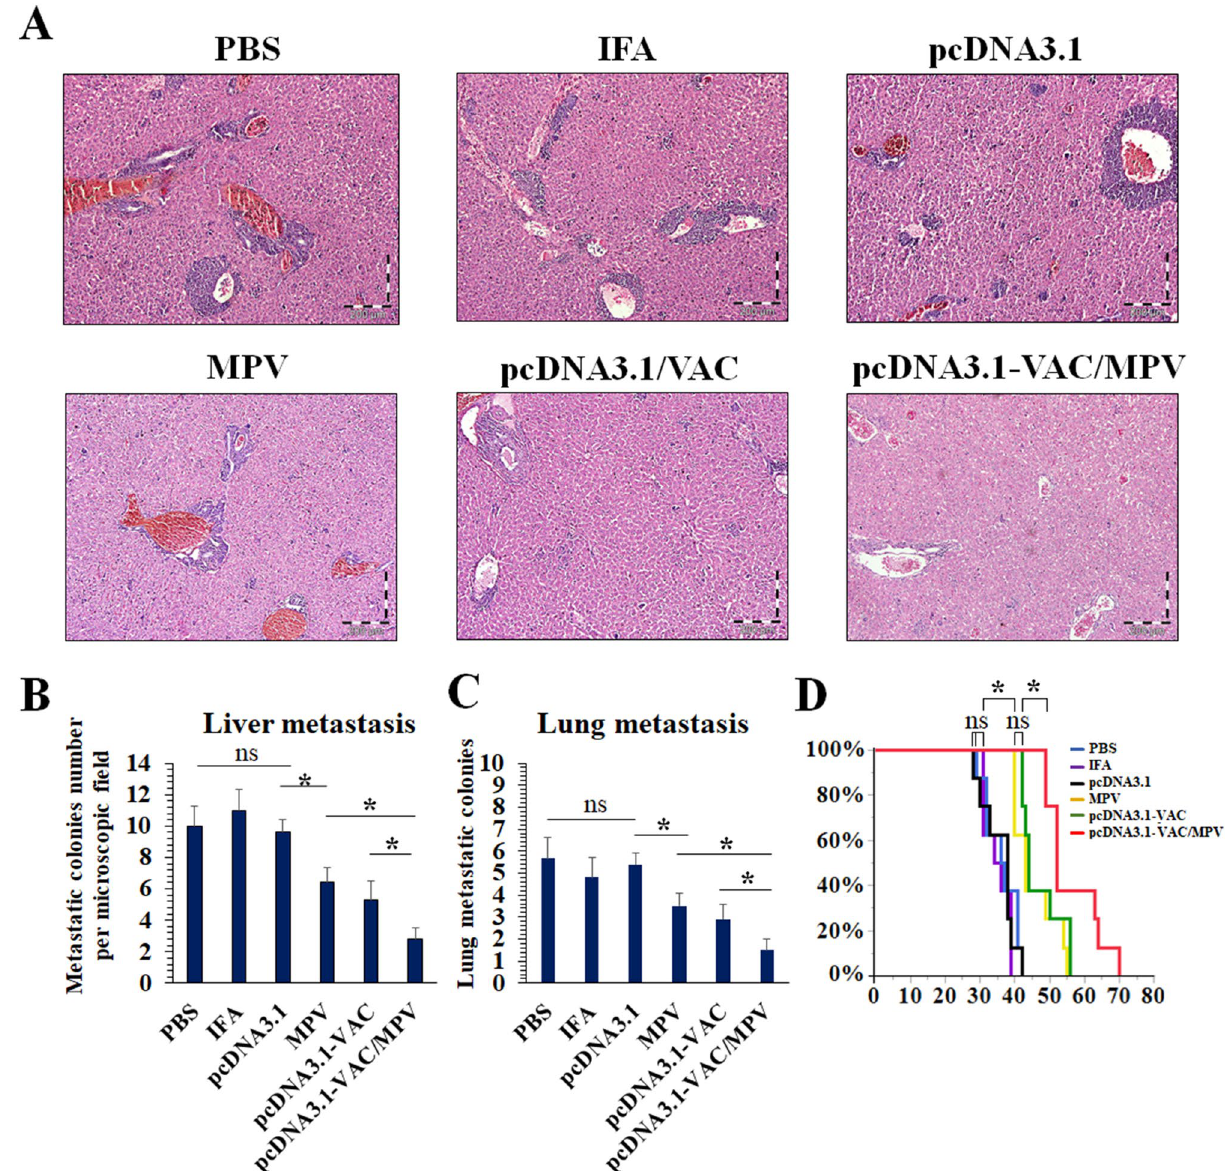
Figure 4. Metastasis and survival time evaluation at different immunization groups. ( A ) H&E stained sections of the immunized mice liver at 40th day after the cancer cells implantation (n = 5). ( B ) Mean metastatic colonies per microscopic field of the immunized mice at 40th day after the cancer cells implantation (n = 5). ( C ) Mean metastatic colonies of harvested lungs at 40th day after the cancer cells implantation (n = 5). ( D ) Kaplan–Meier survival curves of tumor-bearing mice at different immunization groups. (*: 0.05 ≥ P > 0.01, **: 0.01 ≥ P > 0.001, ***: P < 0.001, ns: not